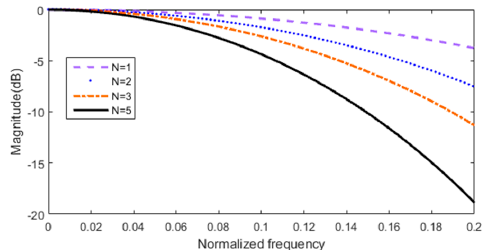
Figure 6. Magnitude response of the 5-order CIC filter with different stages